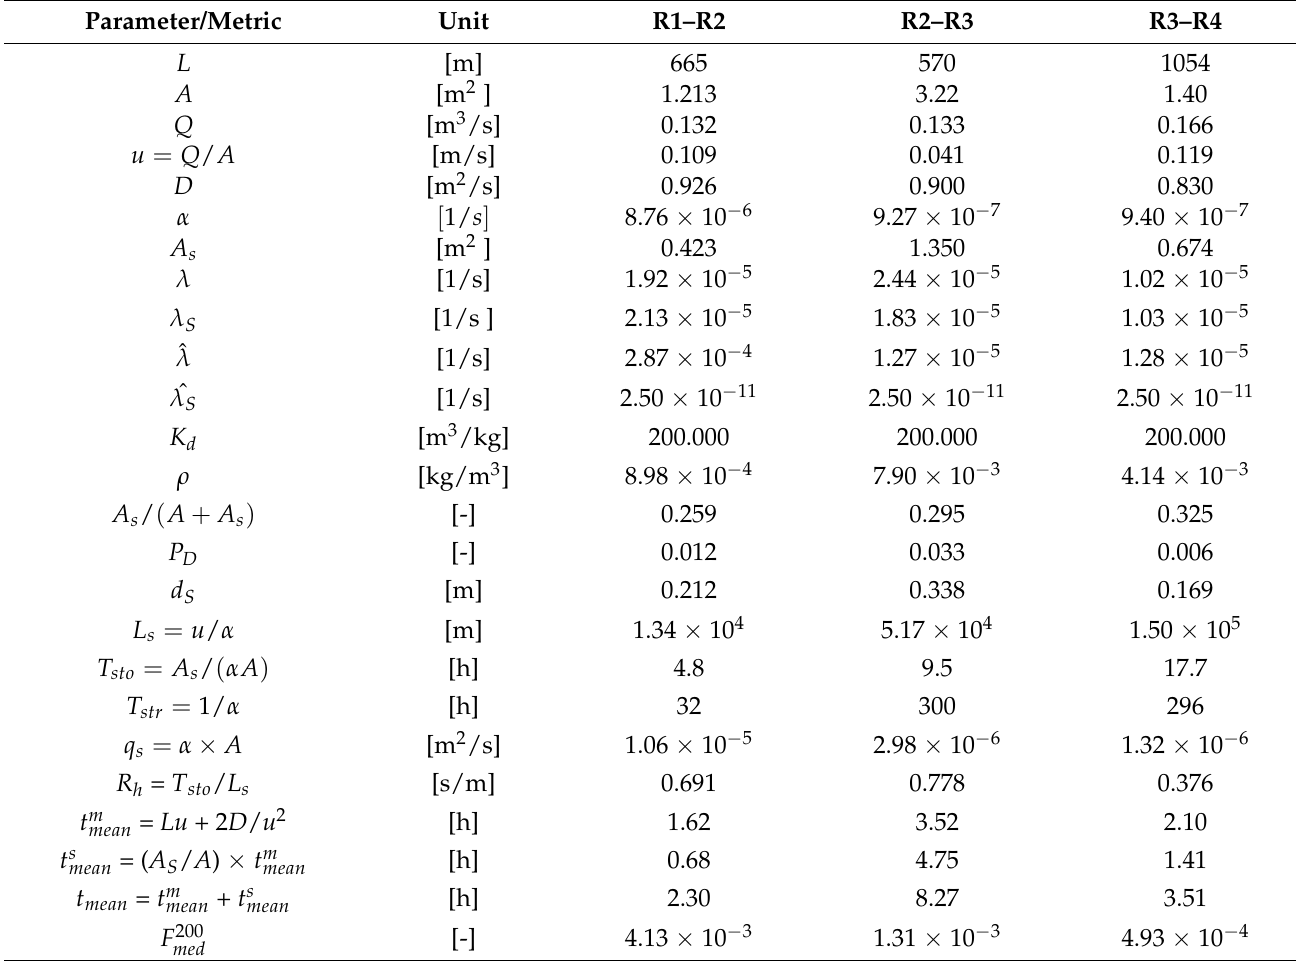
Figure 9. The 32 P activity concentrations observed at R3 and R4, and modeled at R4. Table 5. Parameters and metrics of transient storage derived from 32 P breakthrough curves (BTCs). See Appendix C for explanation of